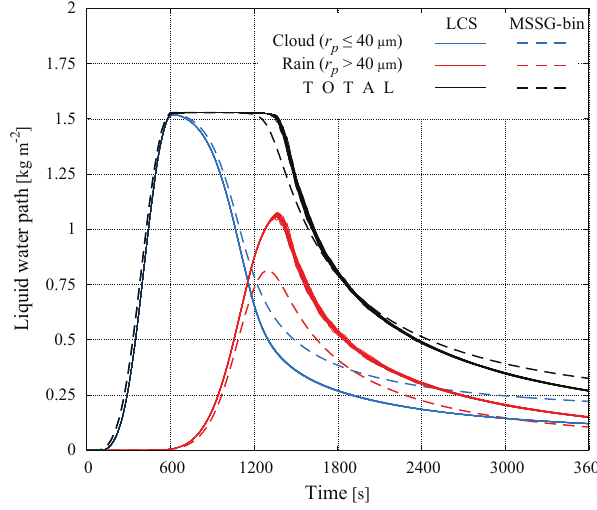
Figure 2. Temporal evolution of liquid water path. The solid lines show the LCS results (all 30 NORM runs are drawn independently while the deviation is small) while the dashed lines show the MSSG- Bin